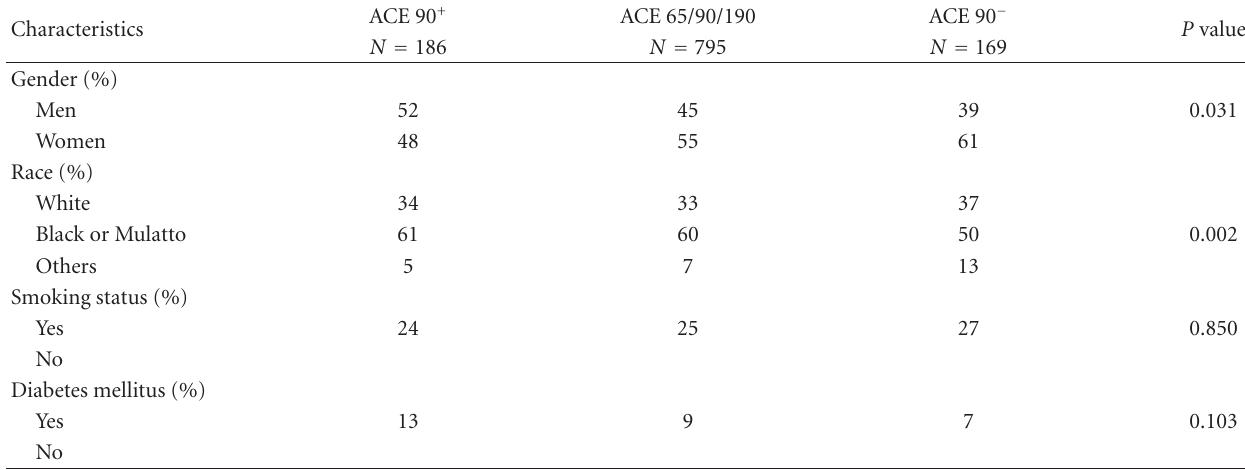
Table 1: Demographic characteristics of the study population according to ACE isoforms.